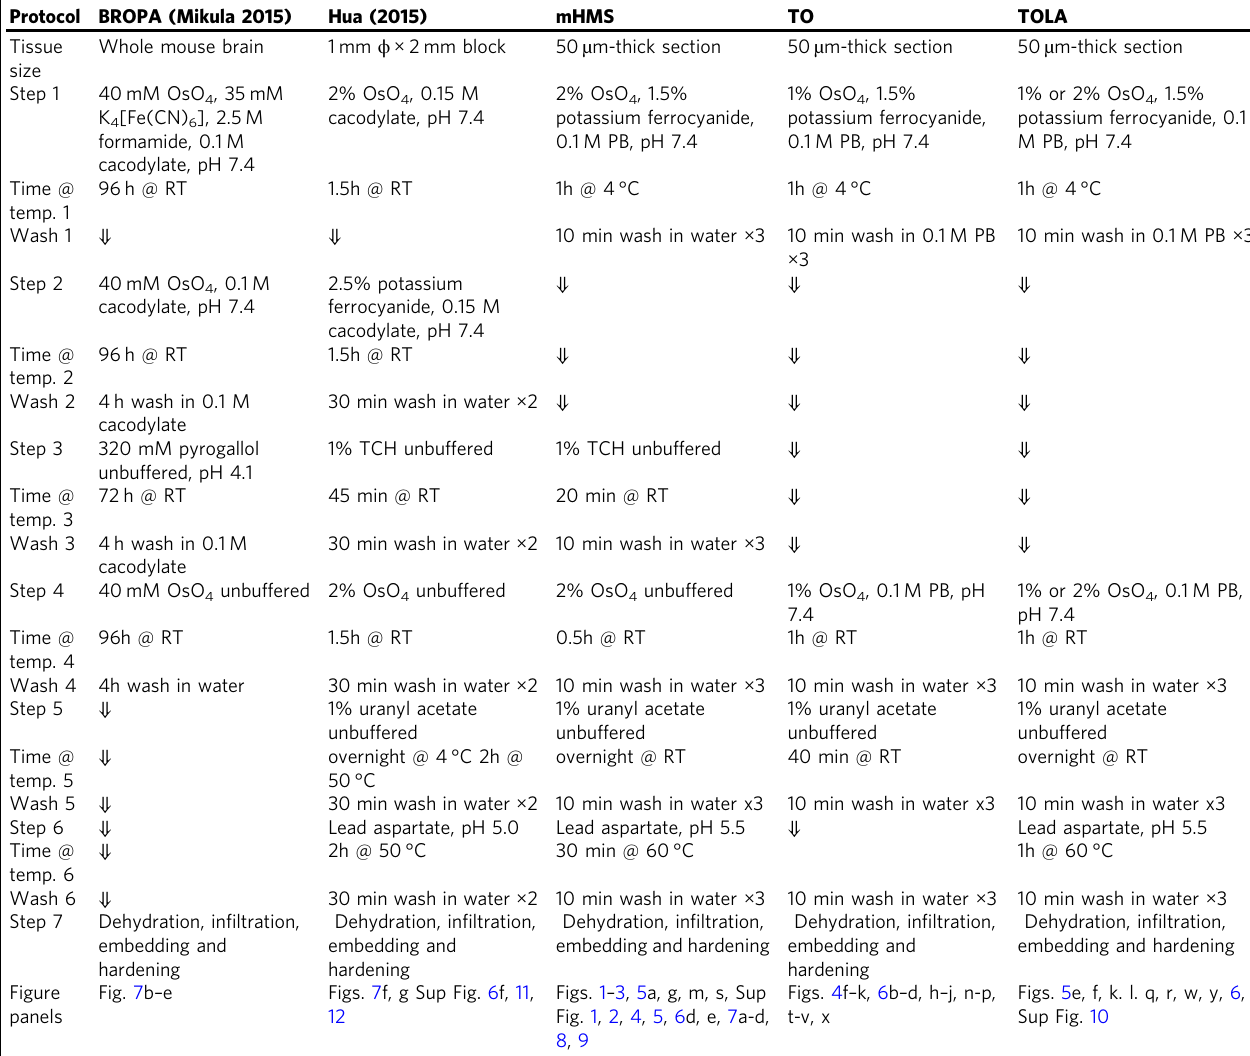
Table 1 Detailed comparison of staining steps in employed staining protocols Protocol BROPA (Mikula 2015)